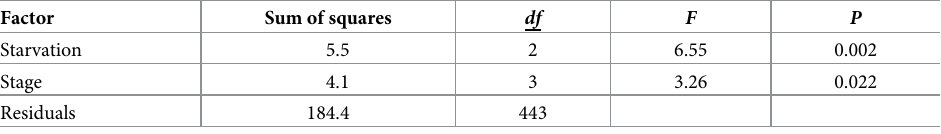
Table 3. Effect of starvation and stage on turning ratio in the outdoor experiment.